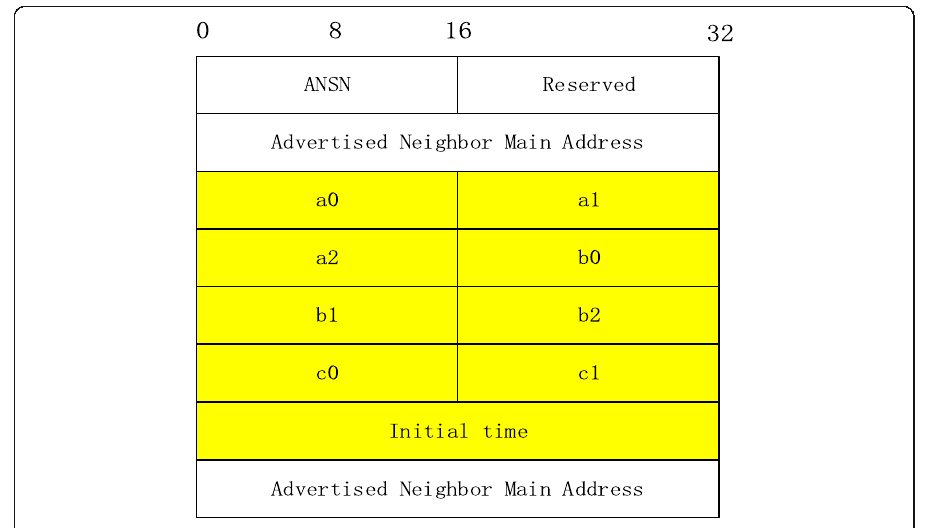
Fig. 3 TC Message structure of